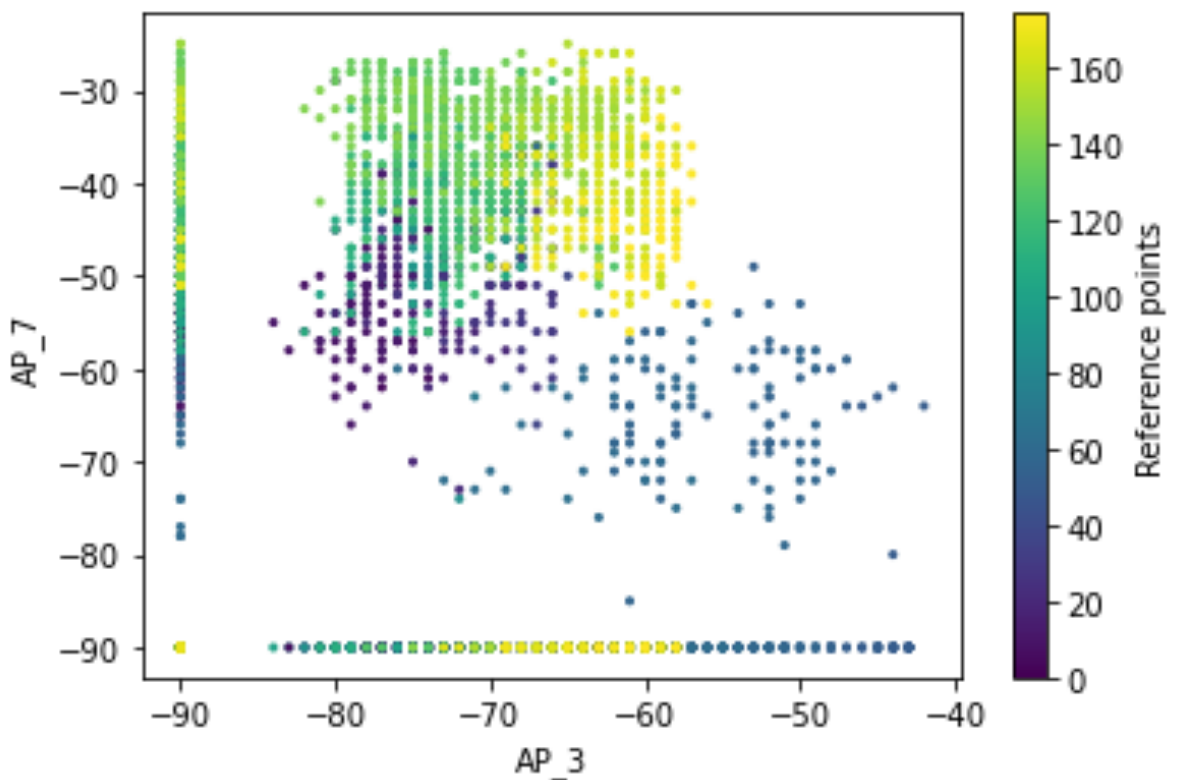
Figure 18. Distributions of RSS for Pair Wi-Fi AP_3 and AP_7 for dataset B.